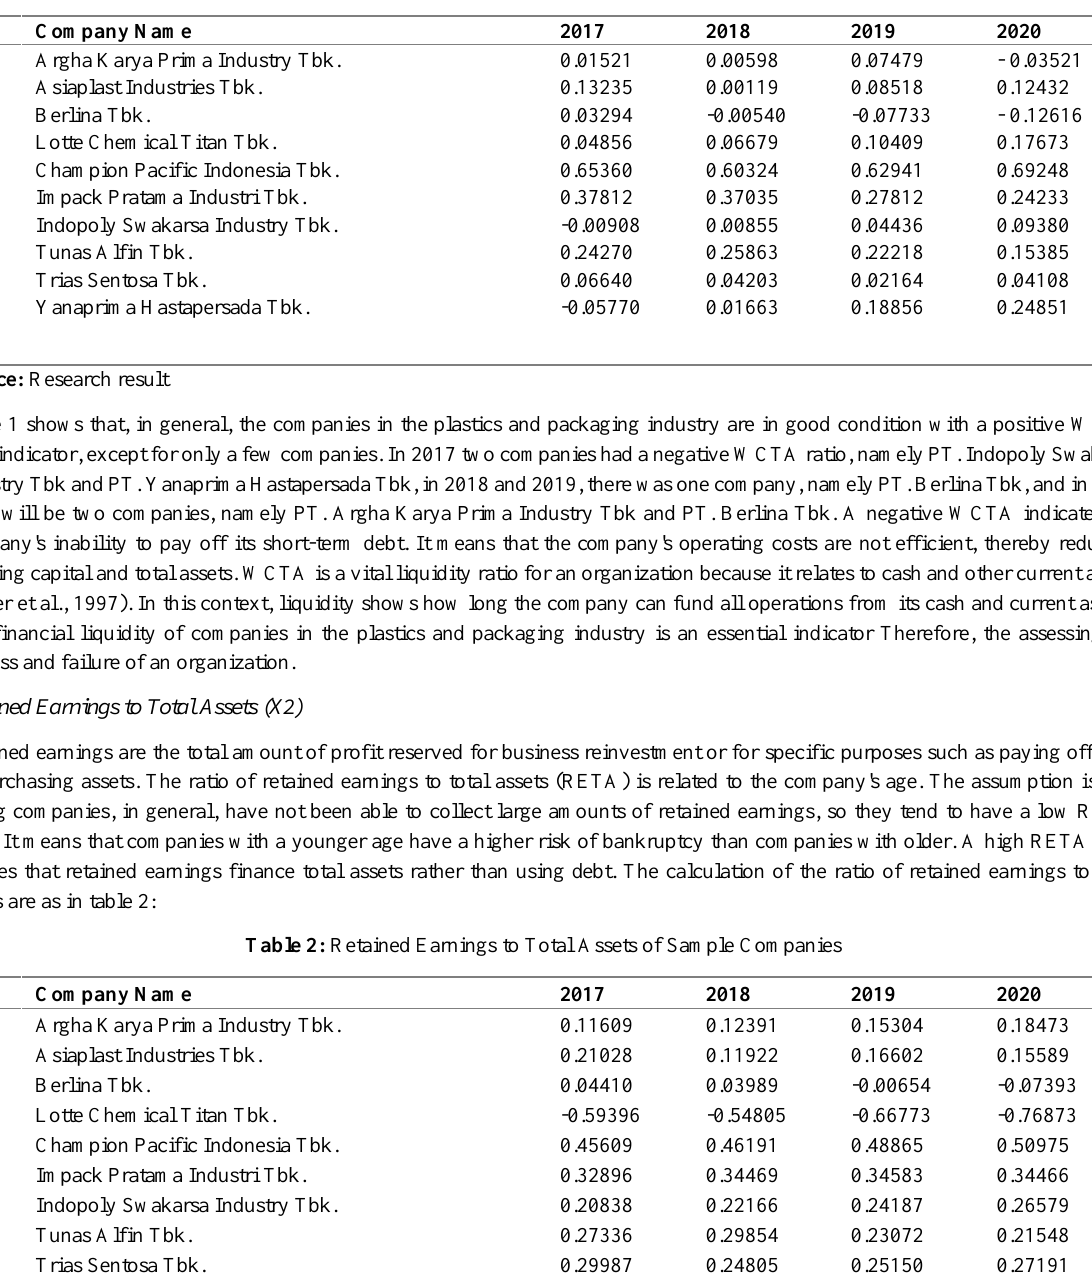
Table 1: Working Capital to Total Assets of Sample Companies